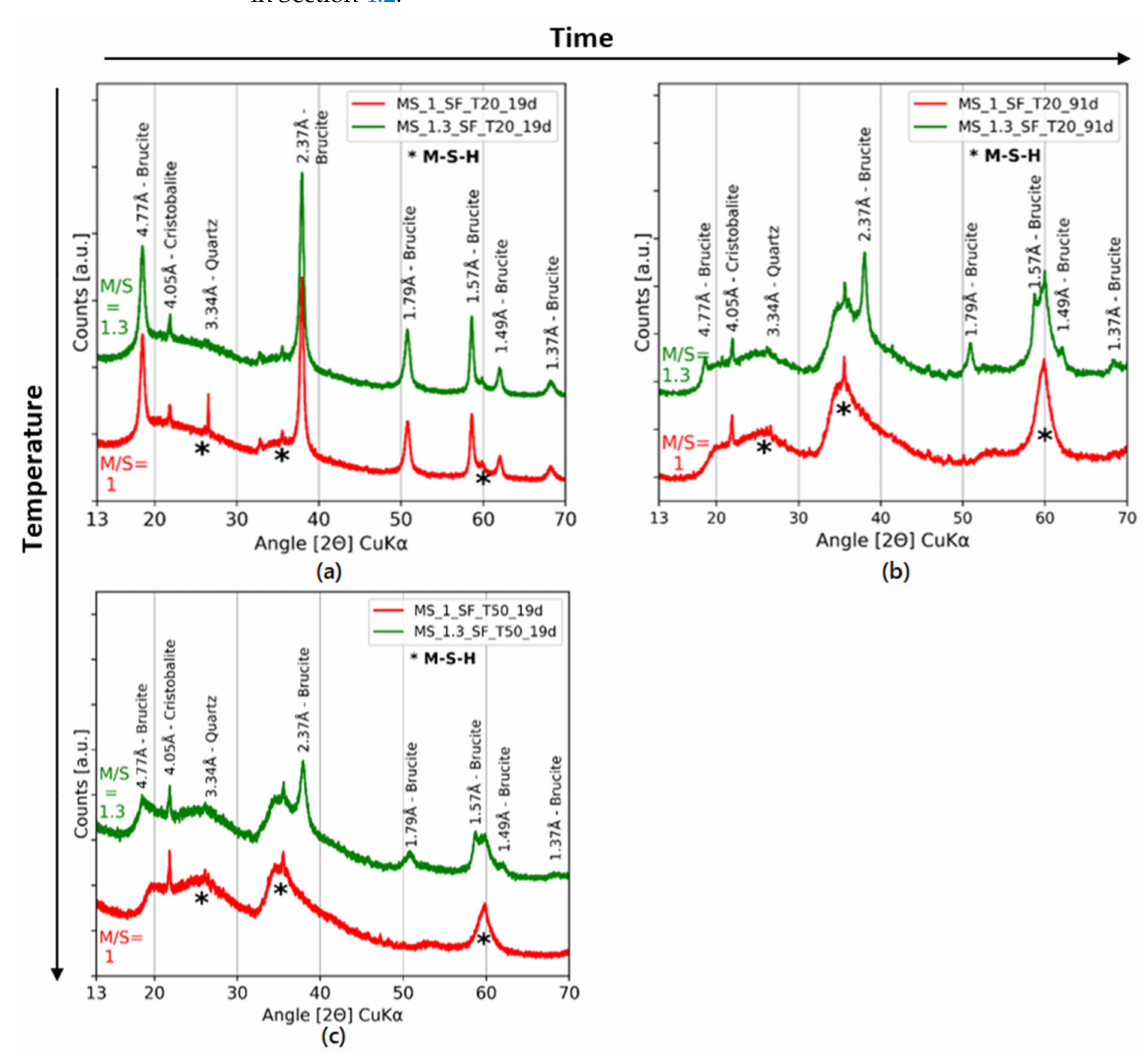
Figure 7. X-ray diffractograms of pastes with silica fume after 19 ( a ) or 91 days ( b ) with 20 ◦ C curing, and with 50 ◦ C curing after 19 days ( c